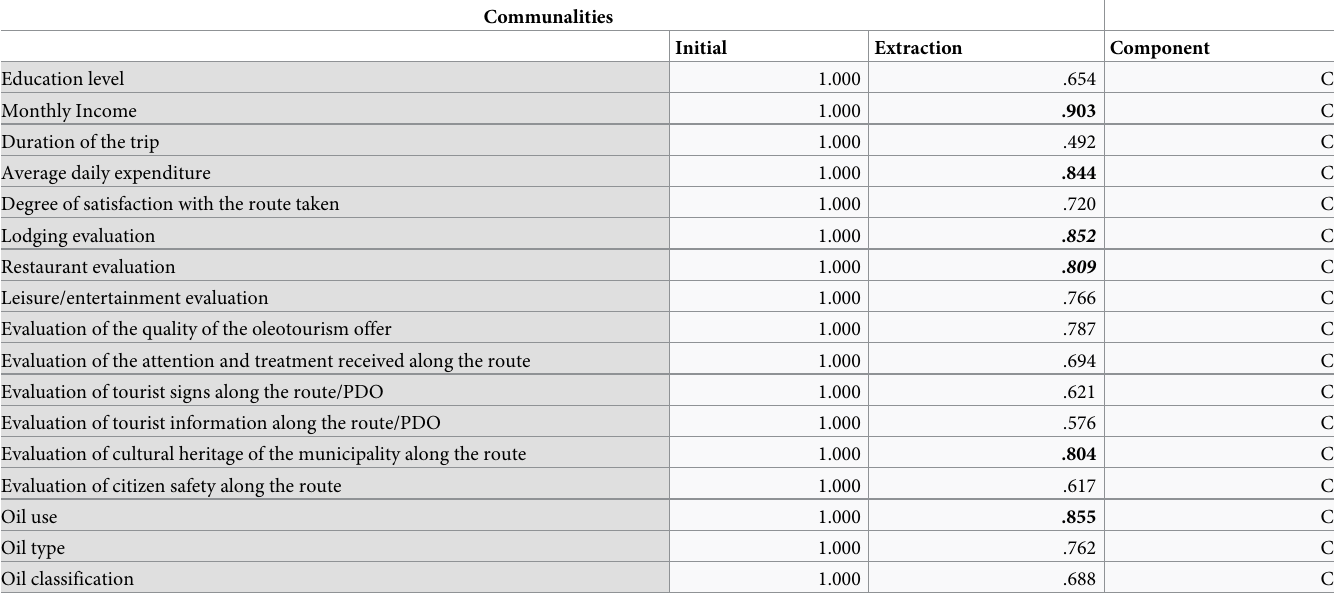
Table 3. Communality matrix.